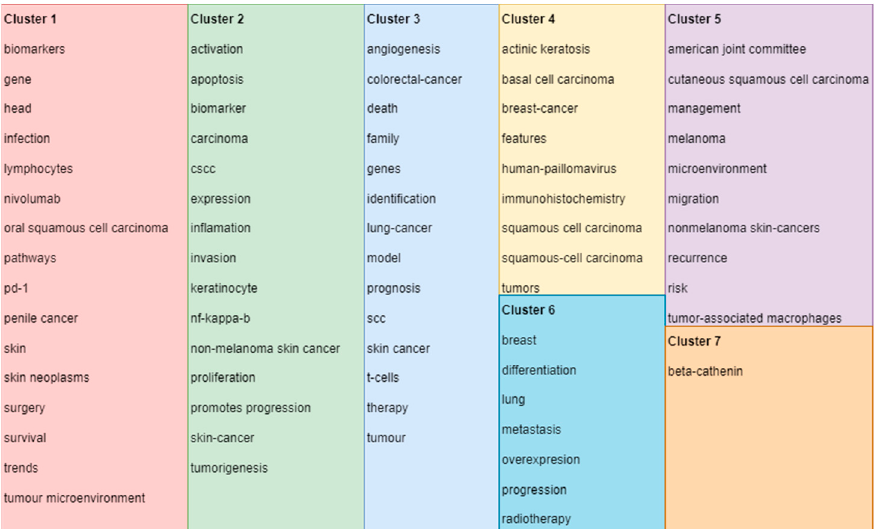
Figure 3. Clusters’ descriptive classifications of keywords based on the scientometric analysis *. (* Colors observed in Figure 3 refer to the defined clusters. Legend of used colors: Cluster 1—red, Cluster 2—green, Cluster 3—blue, Cluster 4—Yellow, Cluster 5—purple, Cluster 6—turquoise, Cluster 7—orange).